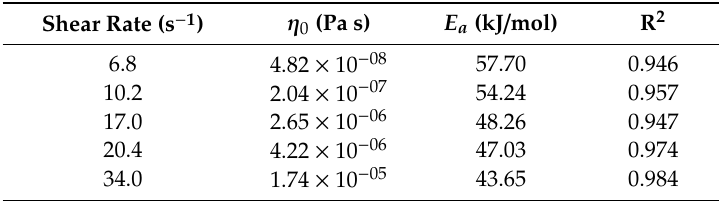
All data are expressed as frequency factor ( η 0 ) and activation energy ( E a